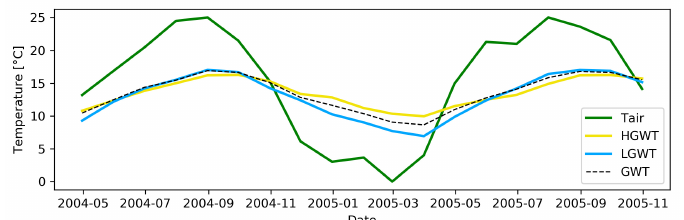
Figure 3. Monthly means of air temperature (Tair) and groundwater temperature (GWT) in all monitoring wells during the observation period. The shown course of average monthly temperature for LGWT and HGWT groups is based on the classification of wells in winter 2004/2005. This corresponds to the distribution and classification of wells shown in Figure